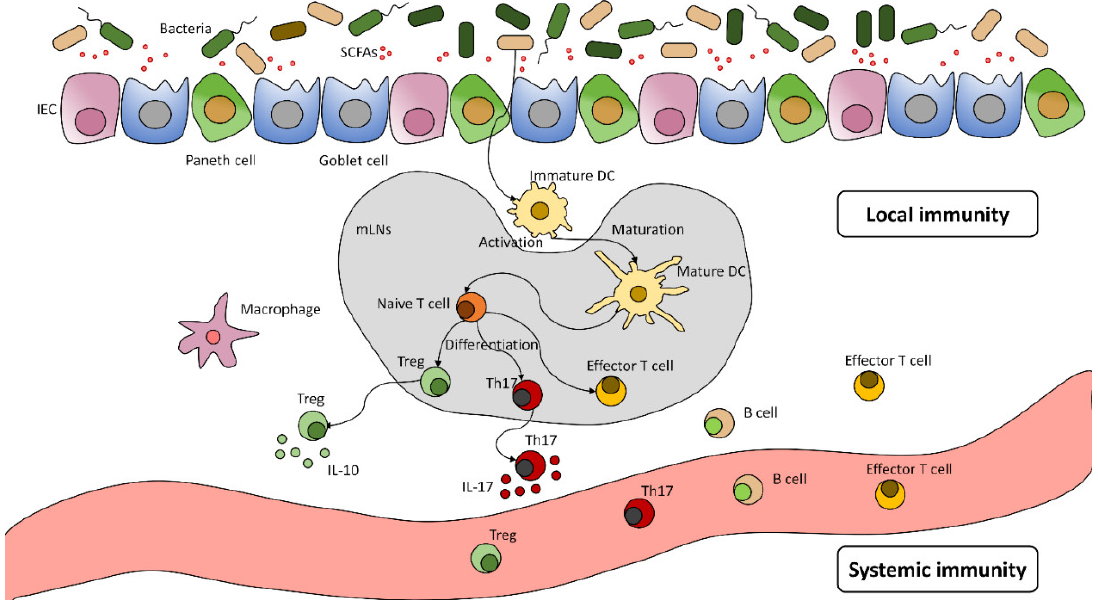
Figure 1. The gut microbiome and its effect on the immune system This figure is a schematic illustration of the gut microbiome affecting the immune cells. The gut microbiome could modify the immune system via direct (local lymph node reaction) and indirect ways (e.g., SCFAs). It causes a local (e.g., DC activation) and systematic response (cytokine release).